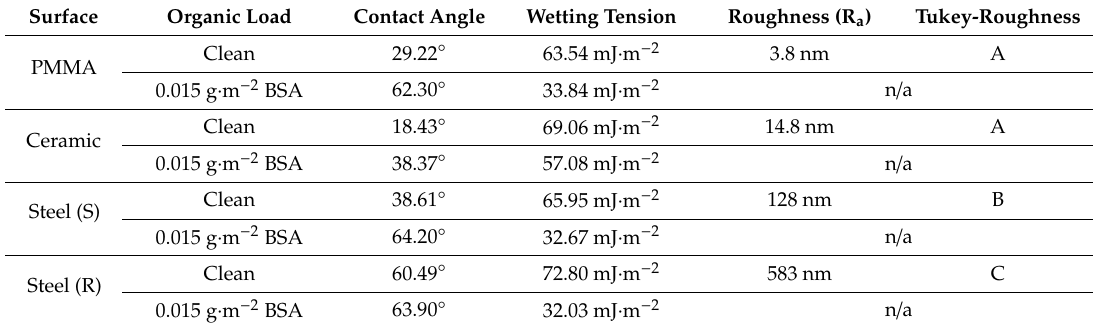
Table 3. Contact angle, wetting tension and roughness of healthcare surfaces. Steel (R) denotes rough steel samples. Steel (S) denotes smooth steel samples. R a indicates no sharing of a “grouping” letter and are significantly di ff erent-ANOVA with post hoc Tukey’s test ( p < 0.05).